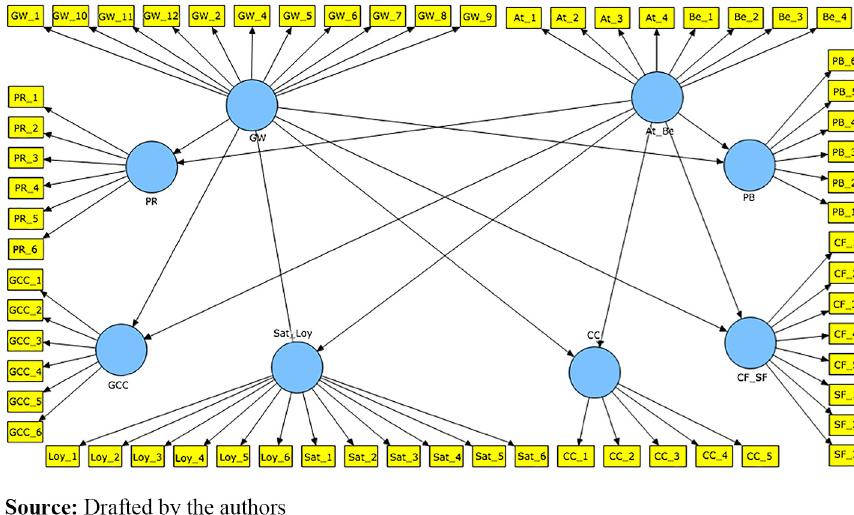
Figure 2. Proposed